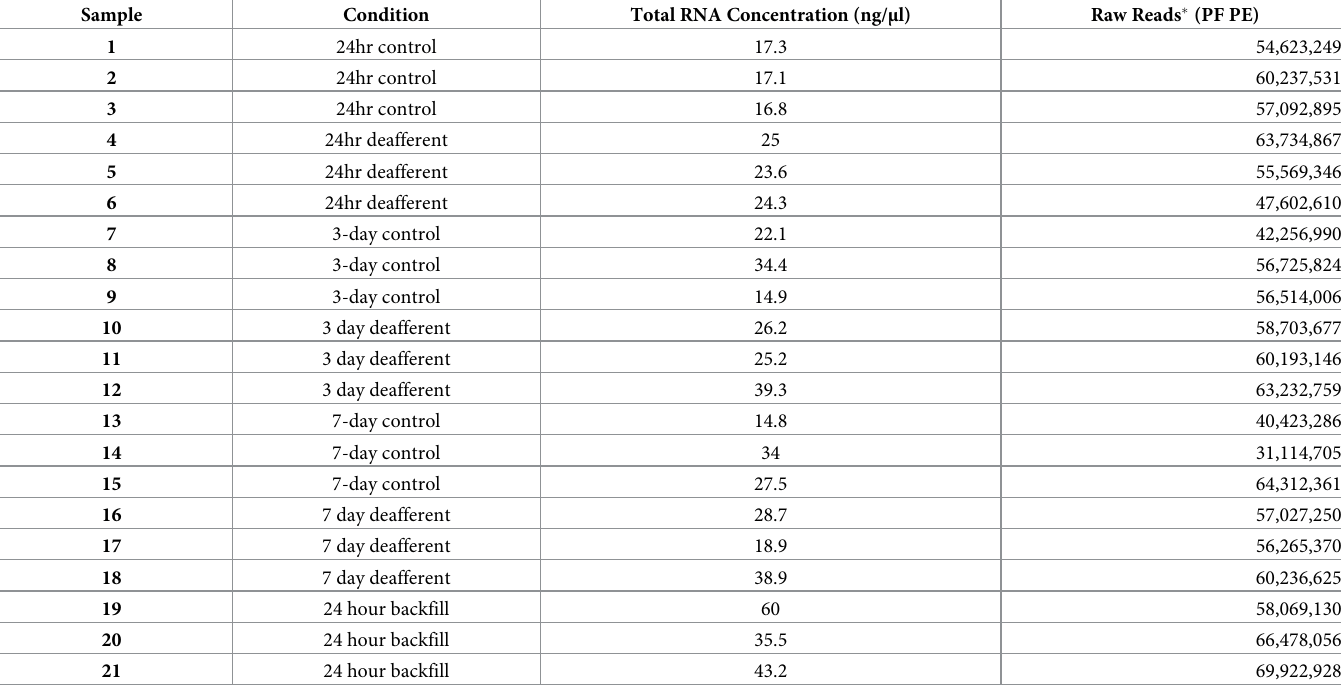
Table 1. Summary of G . bimaculatus prothoracic ganglia samples and their Illumina sequencing.